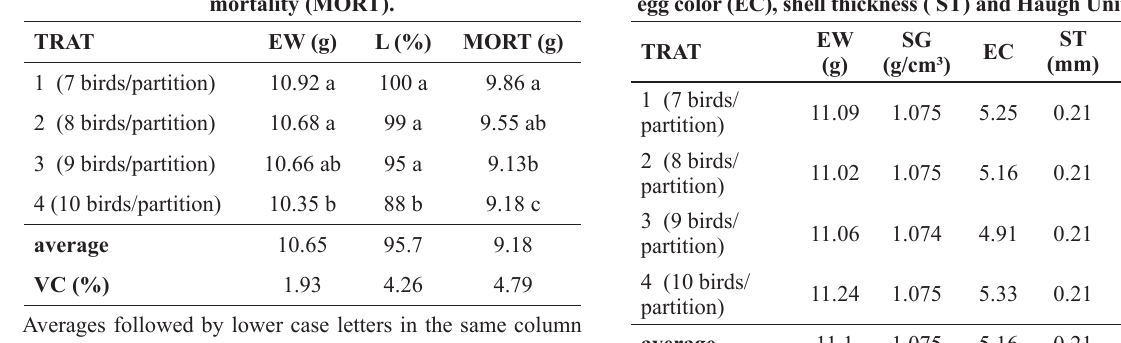
Averages followed by lower case letters in the same column do not differ statistically (Tukey, 5%). VC% means variation coefficient.